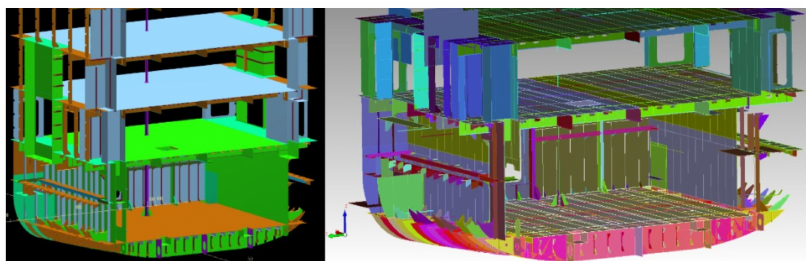
Figure 6. CAD FEM-link scantling and structural optimisation